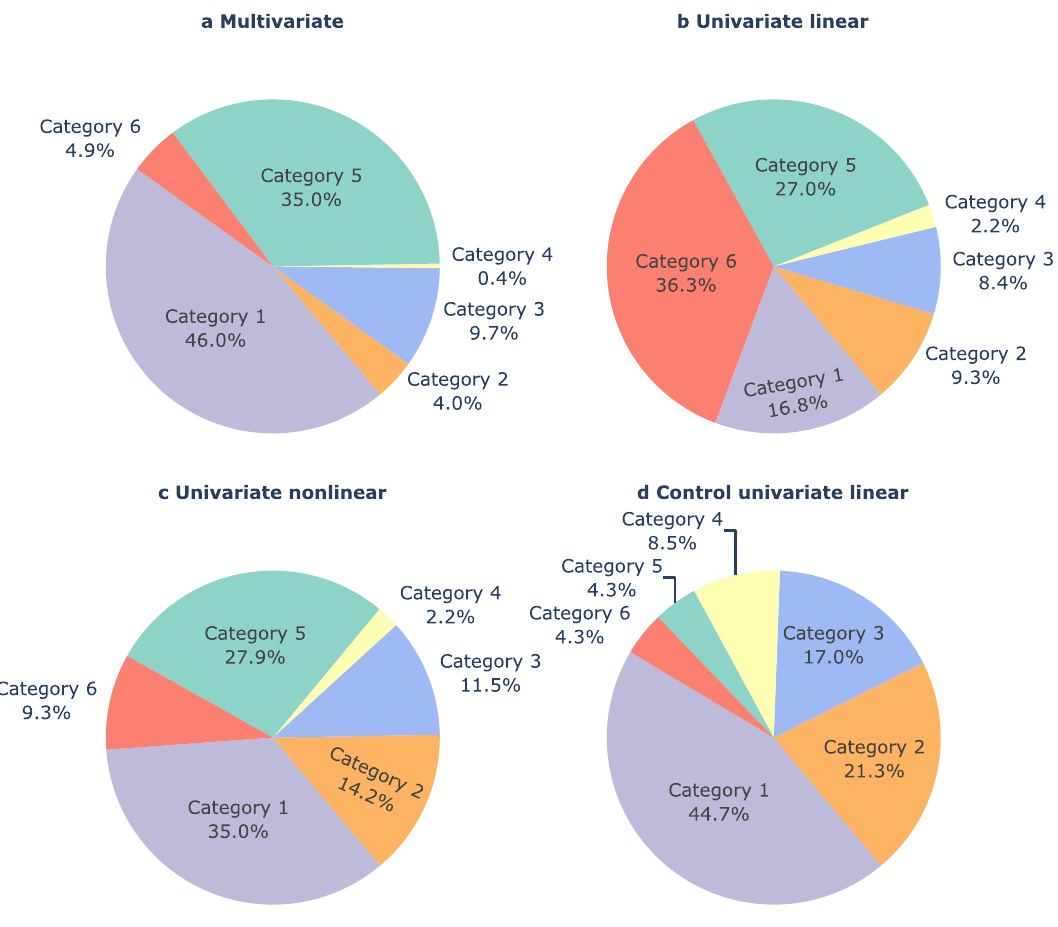
Figure 5. Results for data distribution categorisation. The categorisation of data distributions after experts voting and discussion of doubtful data distributions is presented for each feature group: ( a ) multivariate, ( b ) univariate linear, ( c ) univariate nonlinear, and ( d ) control univariate